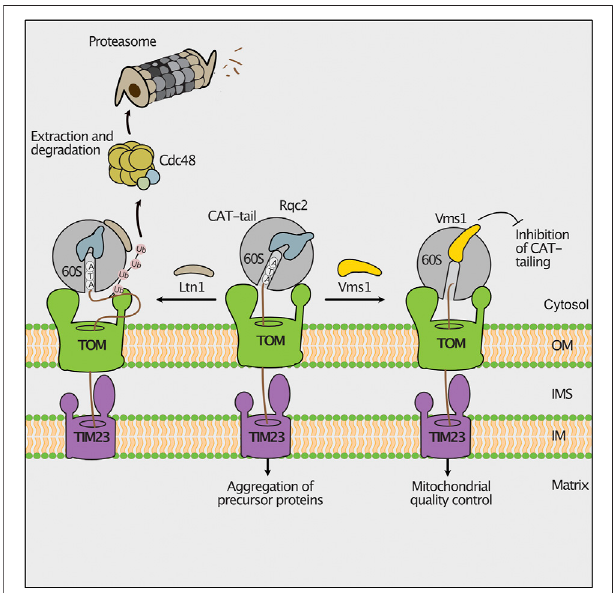
FIGURE3| Ribosomalproteinqualitycontrolduringimport.Stallingduring translation activates the mitochondrial ribosome-associated protein quality control (RQC). Nascent chains can be ubiquitylated by the ribosome bound E3 ubiquitin-ligase Ltn1, allowing their degradation by cytosolic proteasomes (left). If the lysine residues of the stalled polypeptide are not accessible for ubiquitylation, the RQC component Rqc2 will add C-terminal alanine and threonine residues (CAT-tails) to the nascent chain. Imported CAT- tailed proteins form toxic aggregates in the mitochondrial matrix (middle). The peptidyl-tRNA hydrolase Vms1 releases the nascent polypeptide from the ribosome and blocks the Rqc2-mediated CAT-tailing. Upon import, these unmodi fi ed proteins are degraded by mitochondrial proteases